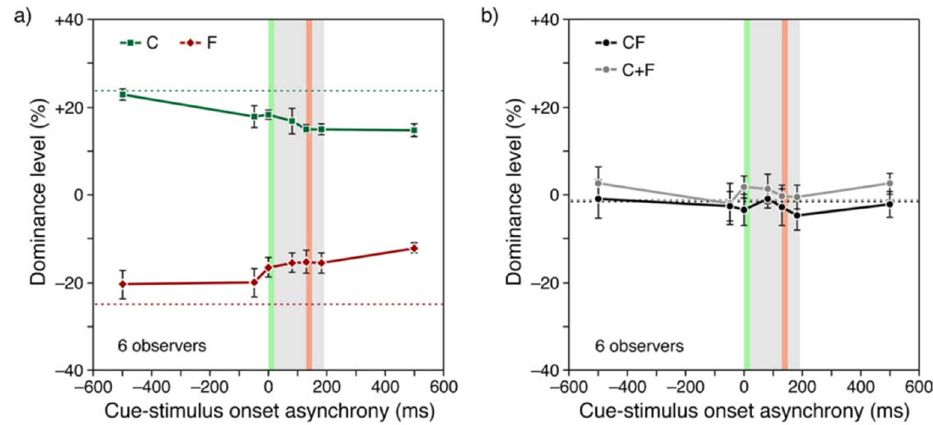
Figure 5. ( a ) Similar paradigm as in the previous figure. In condition C, the central line was offset and there was a line/flank offset in either the left or right stream, randomly chosen in each trial. In condition F, only the line was offset. The x -axis shows an auditory cue was displayed indicating to which stream to attend. Negative values indicate pre-stimulus presentation of the cue. Positive values indicate post-stimulus presentation. Hatched, horizontal lines indicate baseline conditions without the cue. Unsurprisingly, dominance decreases the later the cue is presented, i.e., performance decreases. Importantly, had observers been unable to keep the offsets separate in memory, dominance would be at 0. ( b ) When both offsets are in the same stream, they integrate even when the cue appears 500 ms after stimulus onset. Hence, integration occurs pre-attentively. From Ref. [15].